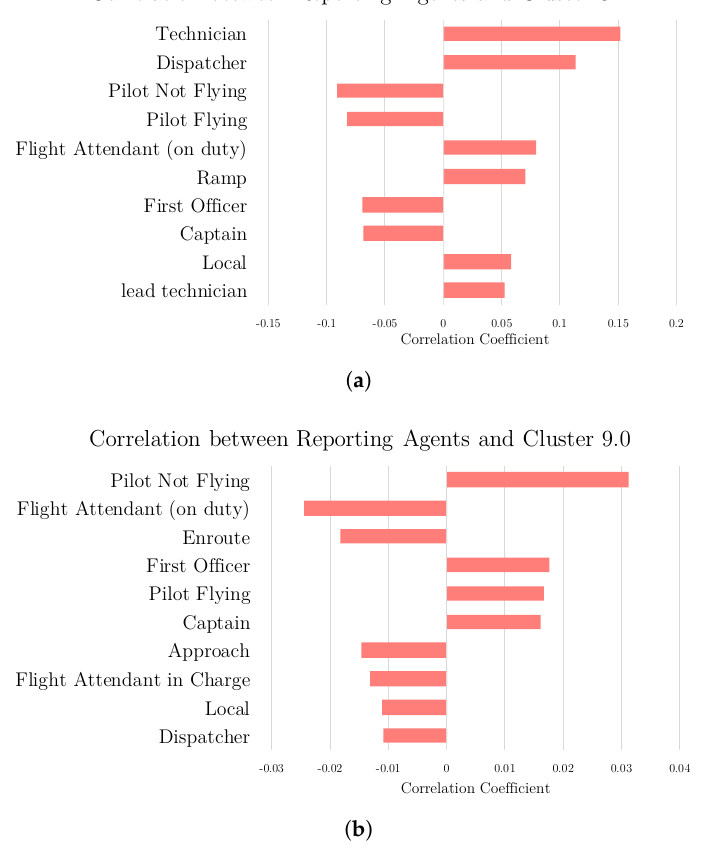
Figure 7. Correlation coefficient between labels for clusters 3.4 and 9.0, and specific reporting agents. ( a ) Cluster 3.4. ( b ) Cluster